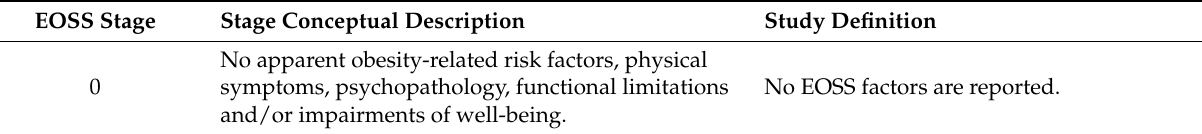
Table 1. EOSS definitions, from Canning et al.